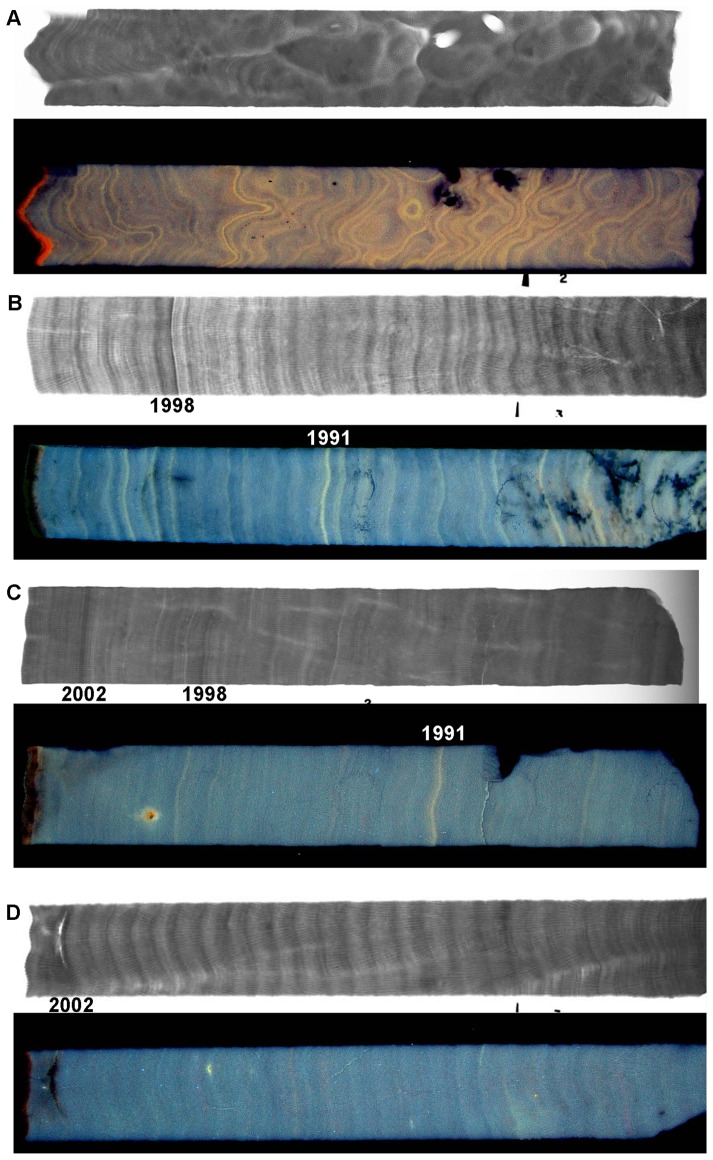
Example positive X-ray prints of short core slices showing annual density banding and photographs under UV light showing luminescent lines and bands.(A) Nelly Bay (Nel 21A_S2) illustrating convoluted growth typical of this inshore site and annual luminescent lines (*off axis core such as this not included in calcification analysis) (B) Pandora (Pan 41A_S3) illustrating 1998 growth hiatus and annual luminescent lines, (C) Rib (Rib 23B_S2) illustrating growth hiatuses in 1998 and 2002 and a bright luminescent line in 1991, and (D) Myrmidon (Myr 35B_S3) illustrating regular density banding typical of this offshore site with faint luminescent bands (minimal flood exposure) and growth hiatus from partial mortality in 2002. X-ray positive: high density  =  dark greys, low density  =  white.